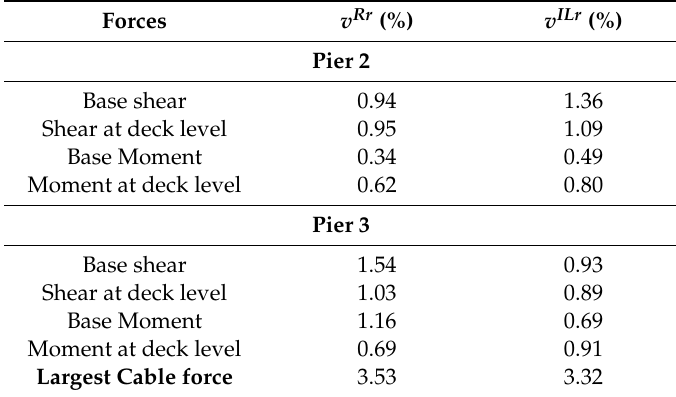
Table 9. Maximum variation of the error ratio for different apparent propagation velocity.